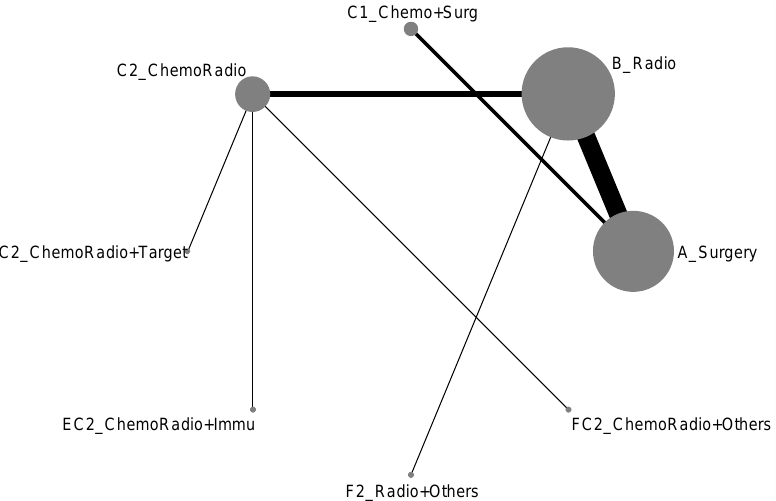
Figure 5. Network map of response rate/disease-free control rate (non-advanced stage).